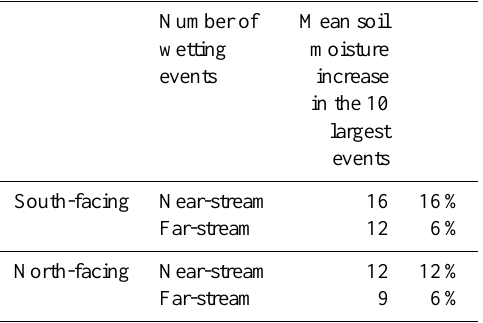
Table 4. Number and size of soil moisture wetting events by aspect and distance from stream, where a wetting event is defined as a period of rainfall during which soil moisture at that location rose by at least 3%.